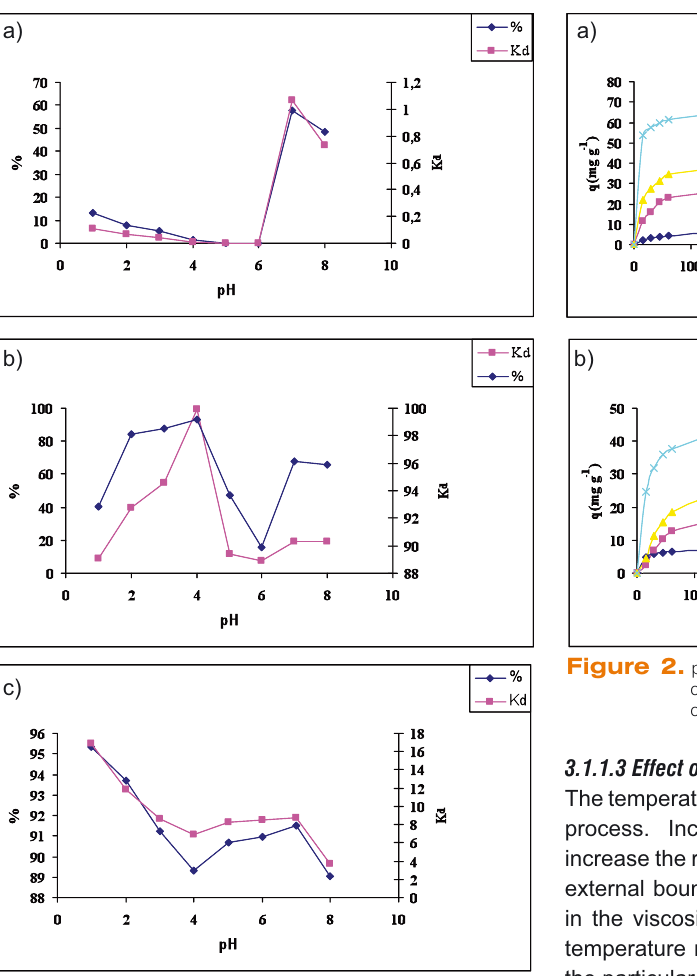
Figure 1. pH effect of Ag(I) sorption on a) As 13P, b) As 14P and c) As 15P (0.01 g resin, C =5 mg L -1 , T=25 o C, 24 hours o contact time).